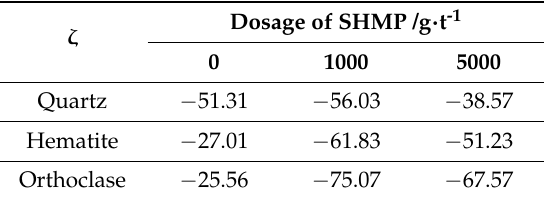
Table 5. ζ potential of quartz, hematite and orthoclase at different dosage of SHMP at pH